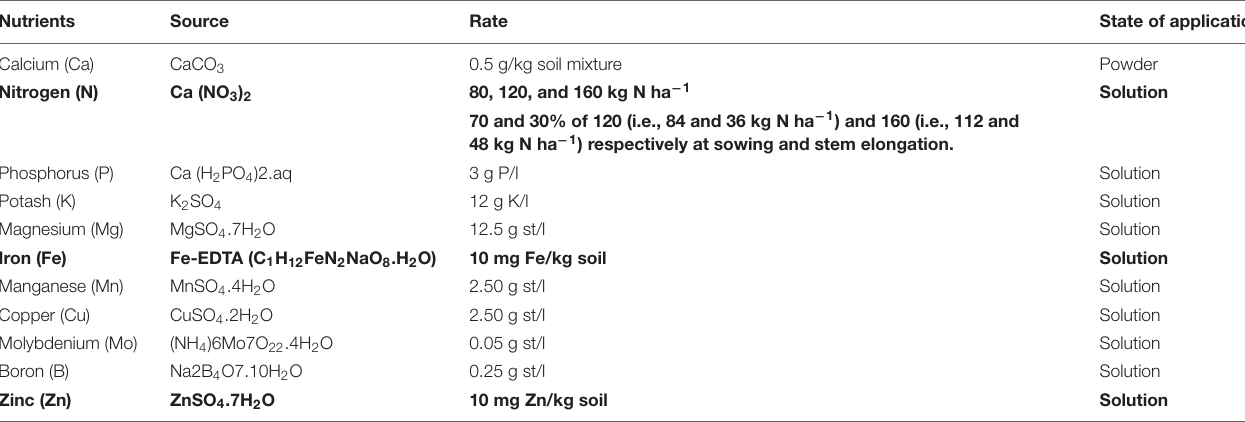
TABLE 2 | Rate of treatment factors and basic nutrients applied in soil.